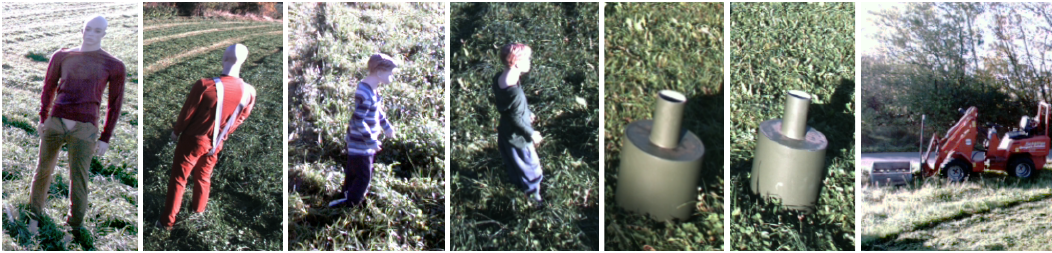
Figure 6. Examples of static